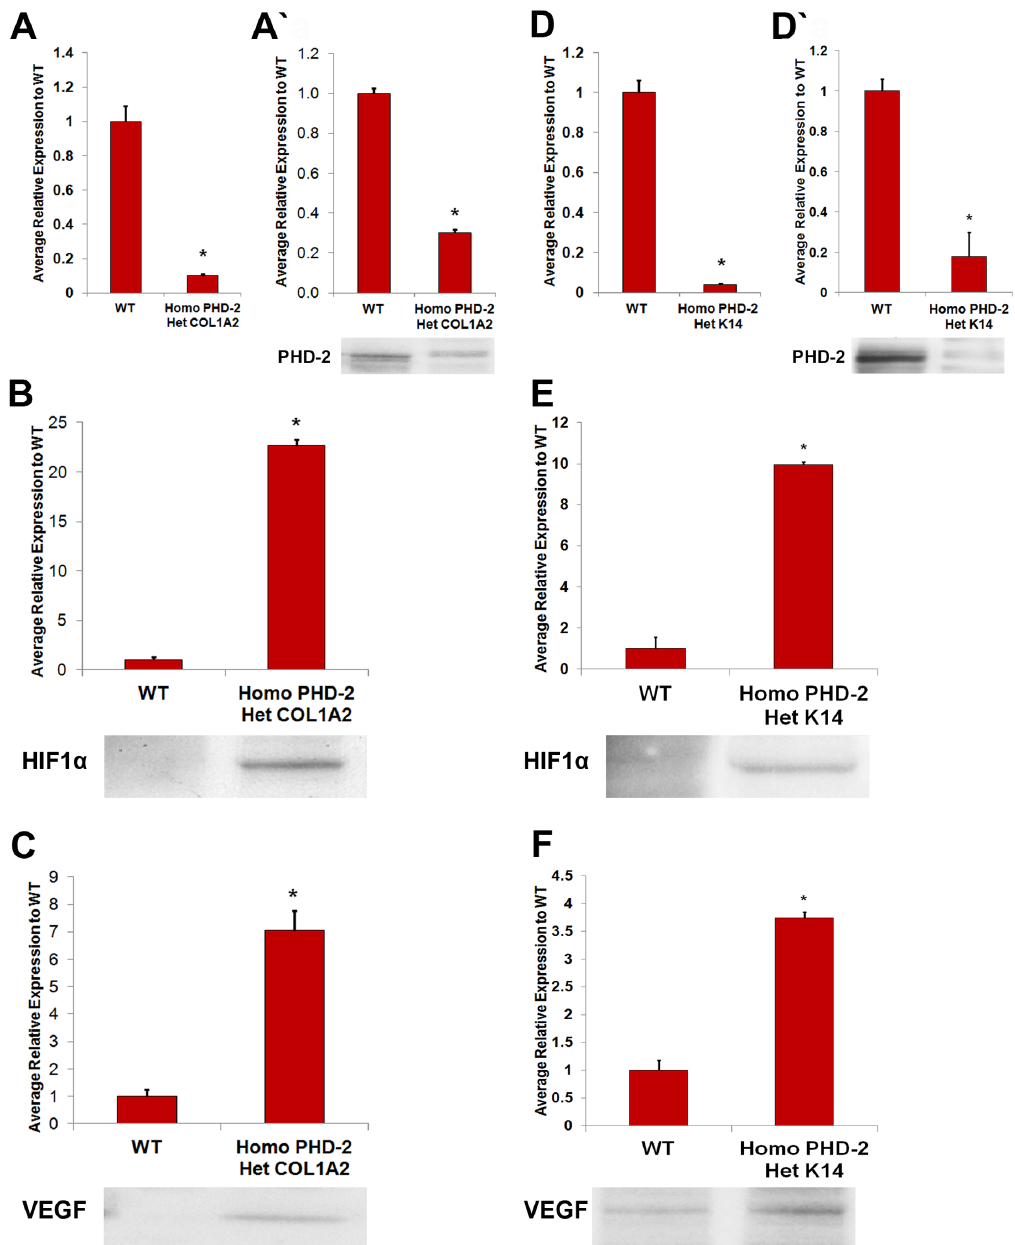
Figure 1. Invitro analysis of PHD-2 knockout and protein quantification. A ) Quantitative polymerase chain reaction for PHD-2 knockout in heterozygous Col1 a 2-Cre-ER/homozygous floxed PHD-2 fibroblasts compared to wild type fibroblasts (*p , 0.05). A’ ) Western blot data for PHD-2 knockout in fibroblasts of heterozygous Col1 a 2-Cre-ER/homozygous floxed PHD-2 mice compared to wild type mice (*p , 0.05). B ) Western blot data for HIF-1 a in fibroblasts of heterozygous Col1 a 2-Cre-ER/homozygous floxed PHD-2 mice compared to wild type mice (*p , 0.05). C ) Western blot data for VEGF in fibroblasts of heterozygous Col1 a 2-Cre-ER/homozygous floxed PHD-2 mice compared to wild type mice (*p , 0.05). D ) Quantitative polymerase chain reaction for PHD-2 knockout in heterozygous K14-Cre/homozygous floxed PHD-2 keratinocytes compared to wild type keratinocytes (*p , 0.05). D’ ) Western blot data for PHD-2 knockout in keratinocytes of heterozygous K14-Cre/homozygous floxed PHD-2 mice compared to wild type mice (*p , 0.05). E ) Western blot data for HIF-1 a in keratinocytes of heterozygous K14-Cre/homozygous floxed PHD-2 mice compared to wild type mice (*p , 0.05). F ) Western blot data for VEGF in keratinocytes of heterozygous K14-Cre/homozygous floxed PHD-2 mice compared to wild type mice (*p ,